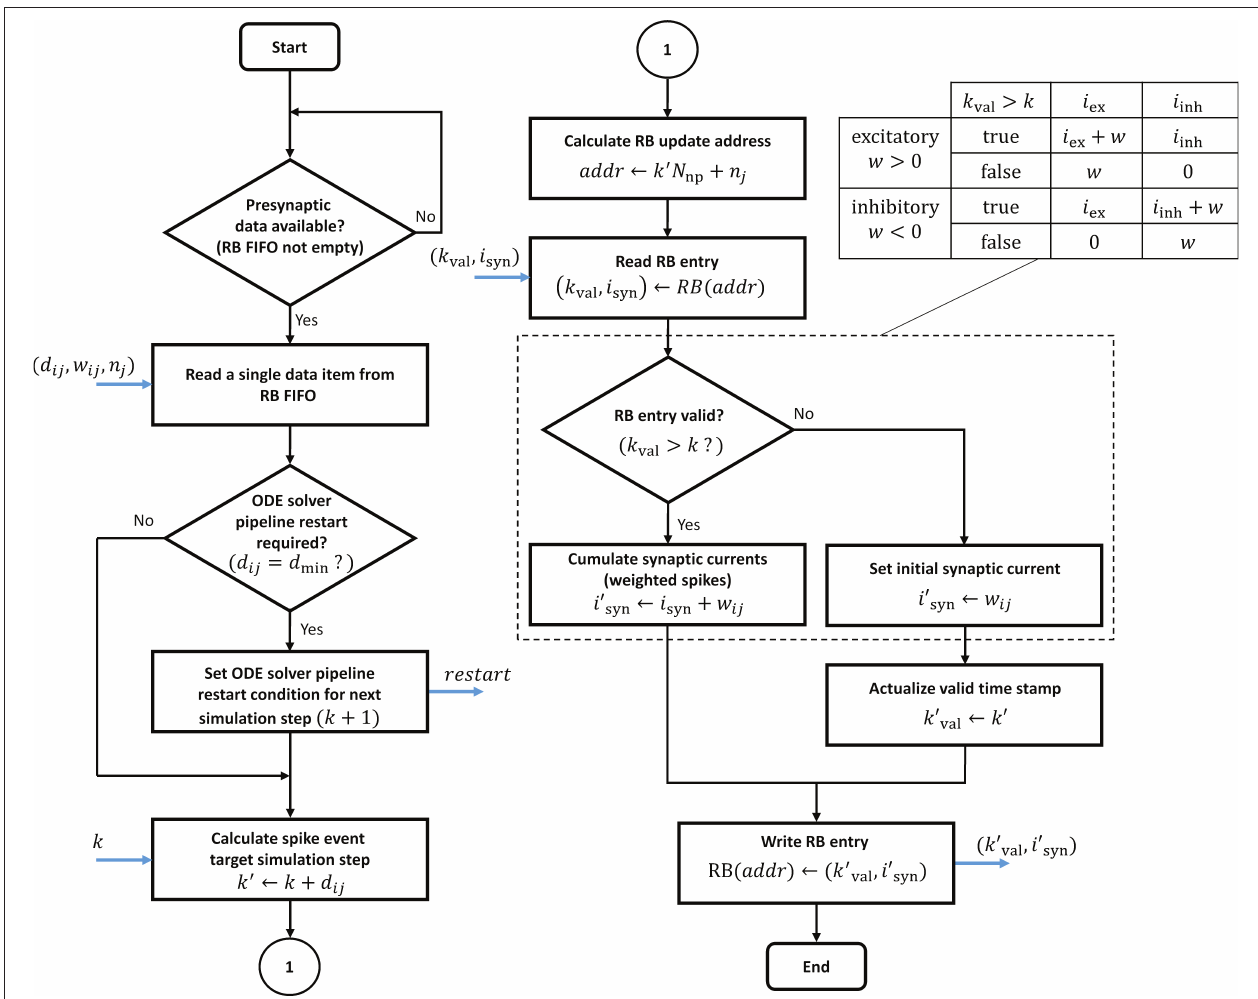
FIGURE 11 | Ring buffer update algorithm. The algorithm is executed by the RB pipelines. The blue arrows indicate in- and out-going data items at different pipeline stages. The dashed box is for simplified illustration and shows the algorithm for the exceptional case of static synapses where a neuron’s excitatory and inhibitory synaptic input can be lumped together. In all other cases, the algorithm expands according to the table on the upper